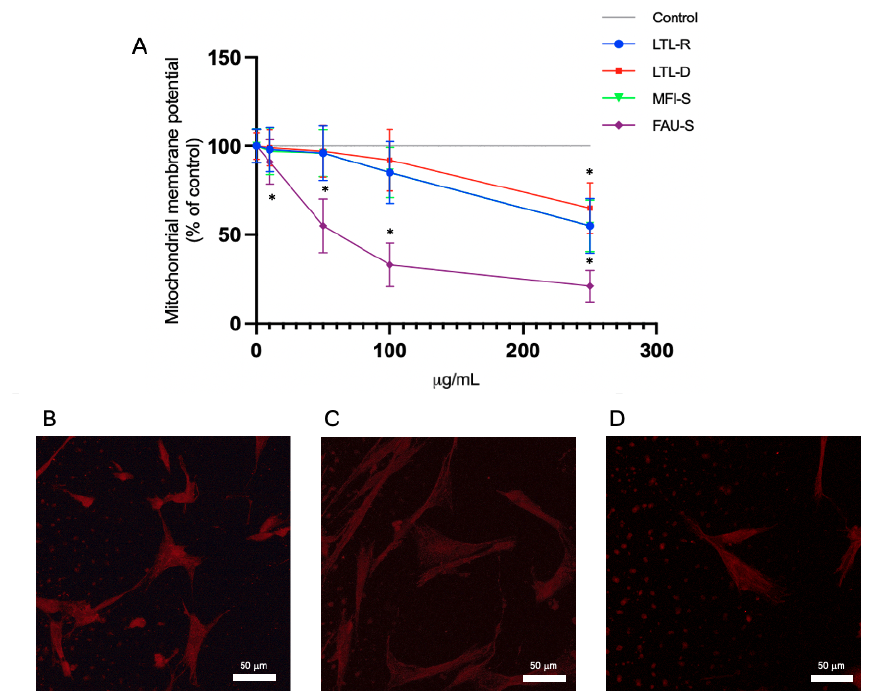
Figure 6. ( A ) Effect of zeolites on mitochondrial membrane potential in lung fibroblast IMR-90 cells. Cells were exposed to different concentration of zeolites for 72 h. The data are expressed as mean ± SD of three independent experiments. * indicate statistically significant differences compared to control. Morphologic chracterization of mitochondrial disruption by MitoTracker Red staining: ( B ) control, ( C ) cells with 50 µ g/mL FAU-S, and ( D ) cells with 100 µ g/mL FAU-S were visualized using cofocal laser microscopy. Scale bar: 50 µ